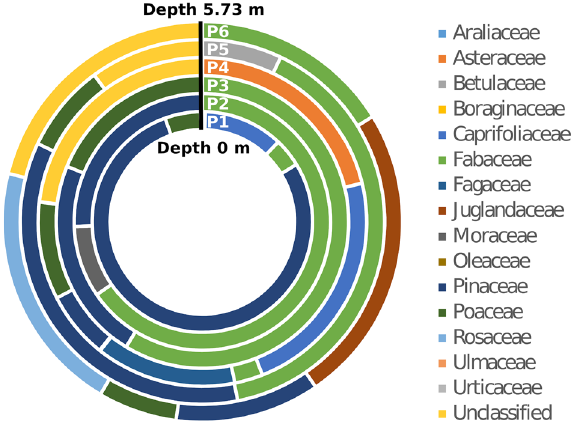
Figure 5. Doughnut chart showing plant diversity at family level at the six depths of the firn core. Relative abundances of taxa are symbolized by the width of the corresponding arch. Unclassified represents plant taxa with no blast hit in the reference database.